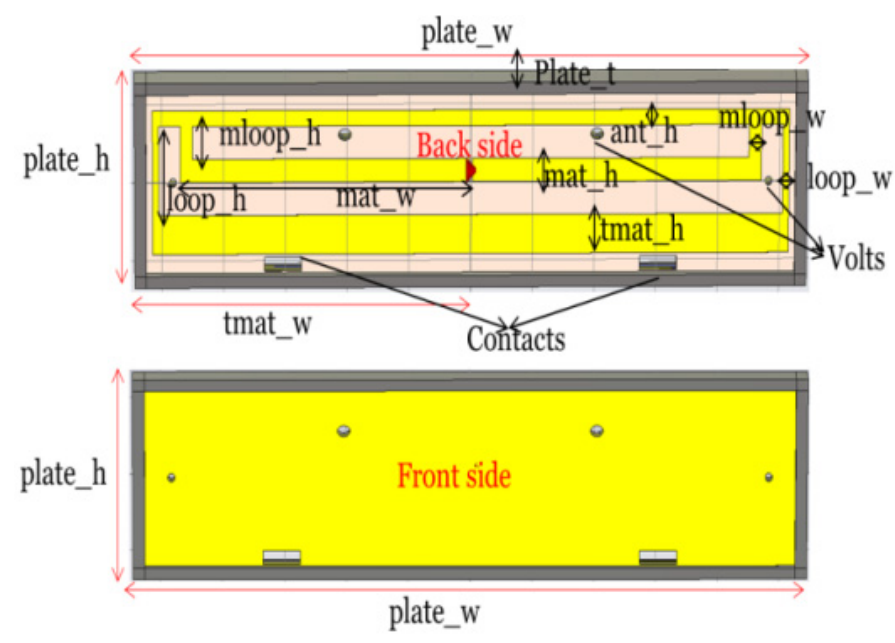
Figure 2. Parameters and design structure of the RFID tag antenna without bumper.